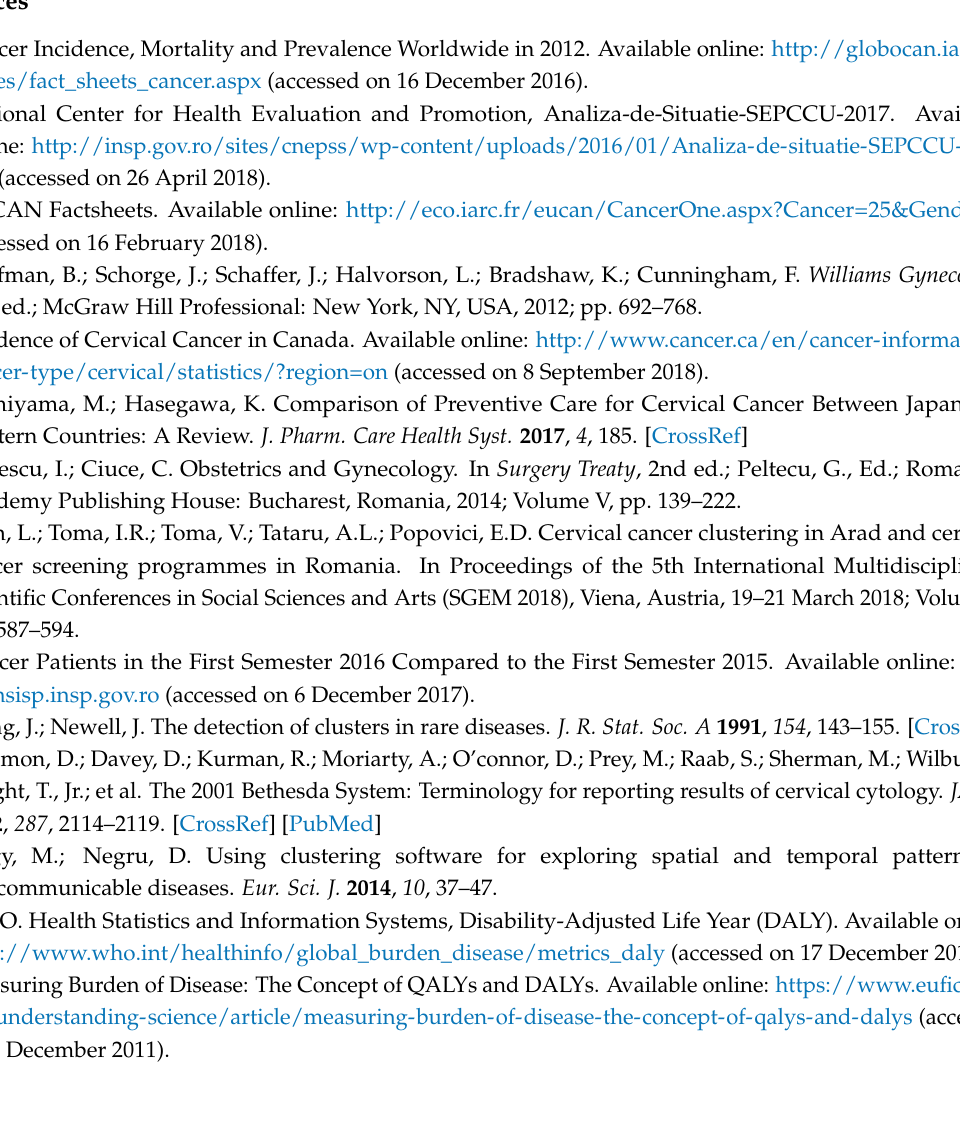
Figure A1. Female genital cancer incidence Arad to Figure B1. Female genital cancer incidence Arad to 100,000.